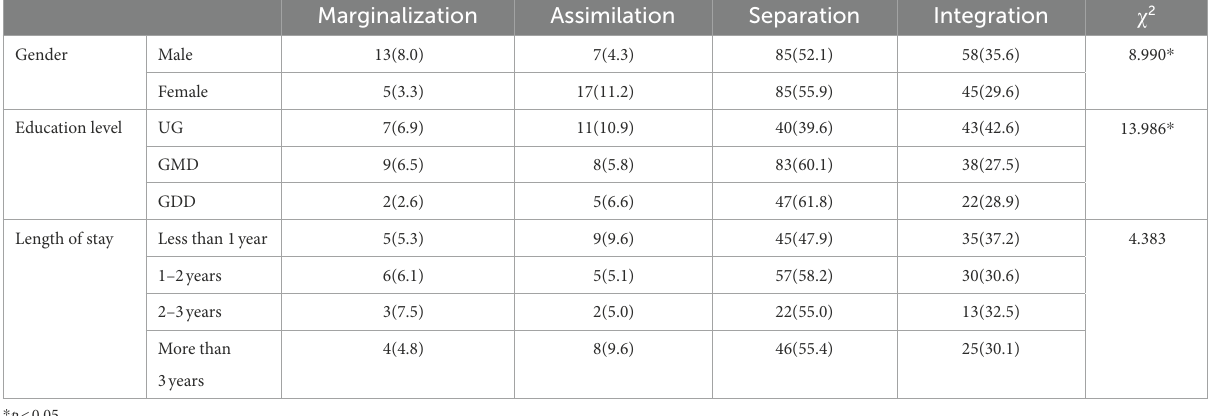
TABLE 4 The Chi-square test of distribution of acculturation strategies by demographic variables [ n (%)].